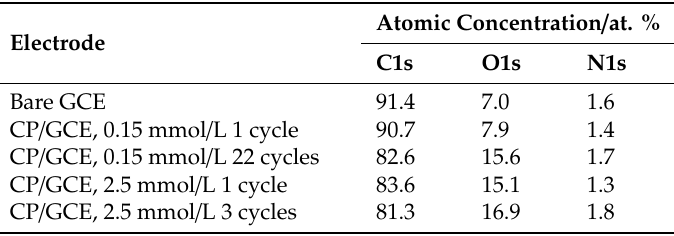
Table 1. Atomic compositions on bare GCE and grafted GCE (CP / GCE) using 0.15 mmol / L and 2.50 mmol / L 4-CBD at di ff erent grafting